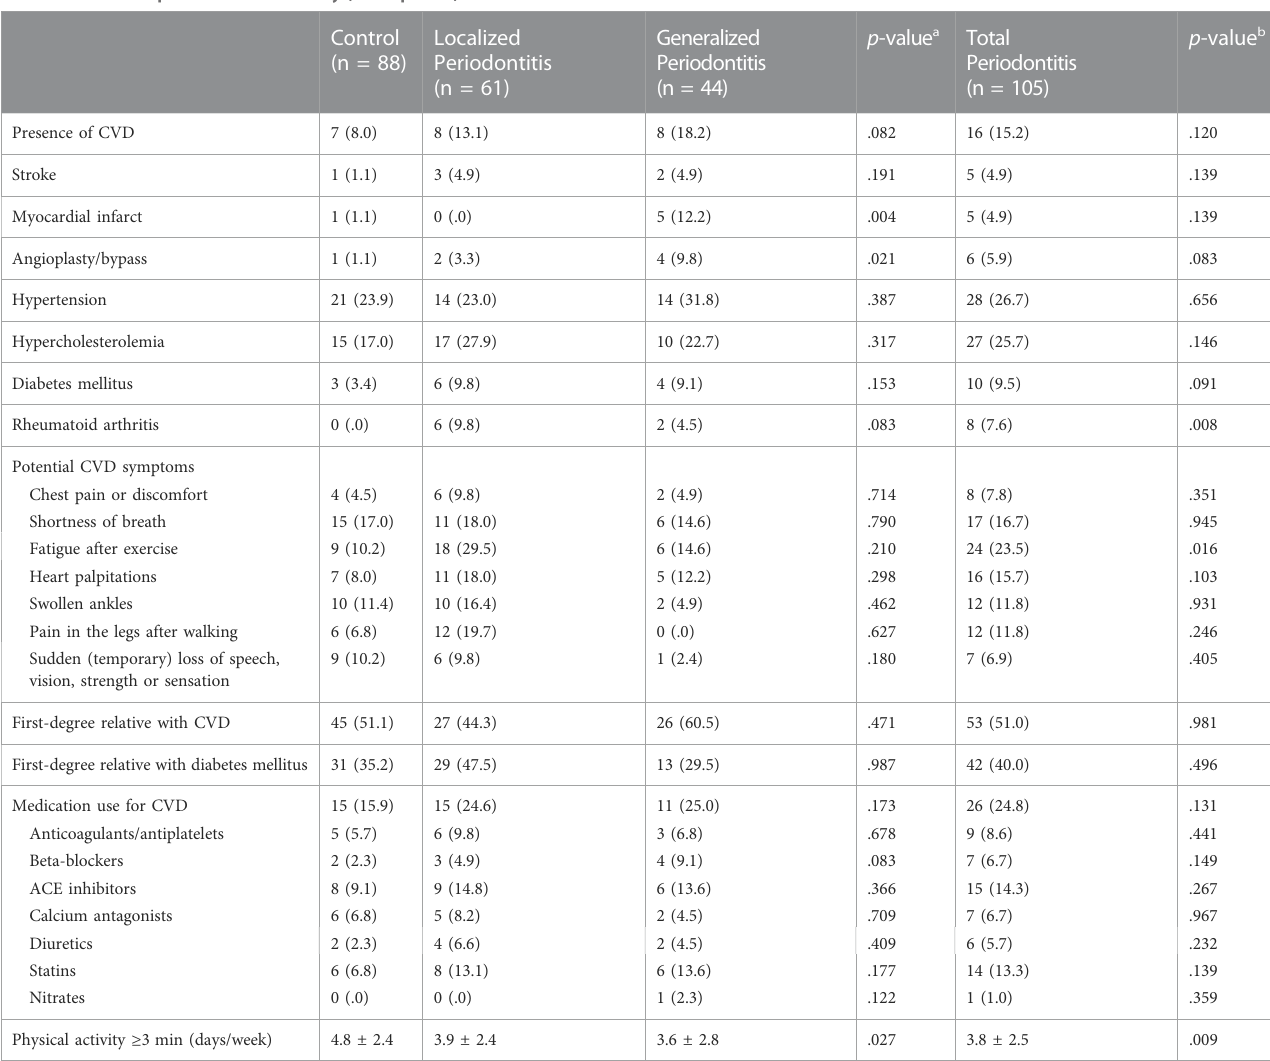
TABLE 3 Data from patient ’ s health history